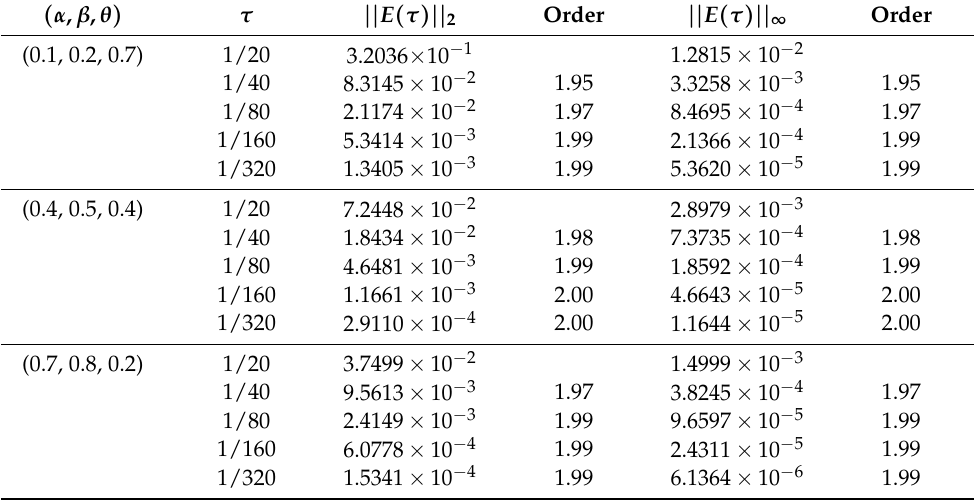
Table 3. Errors and temporal convergence orders with h 1 = h 2 = 1 initial